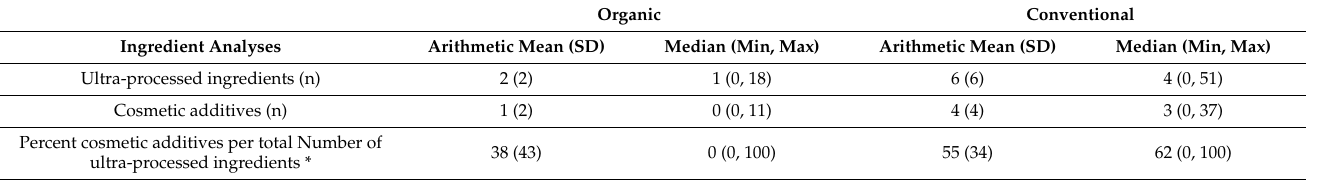
Table 2. Analysis of ingredient lists for 8,240 organic and 72,205 conventional products. All values are rounded to a whole digit.